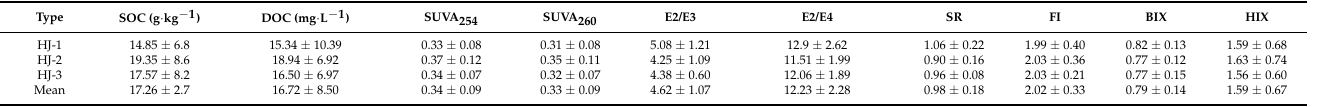
Table 3. Overall mean values of DOM characteristic parameters in fissured soils.